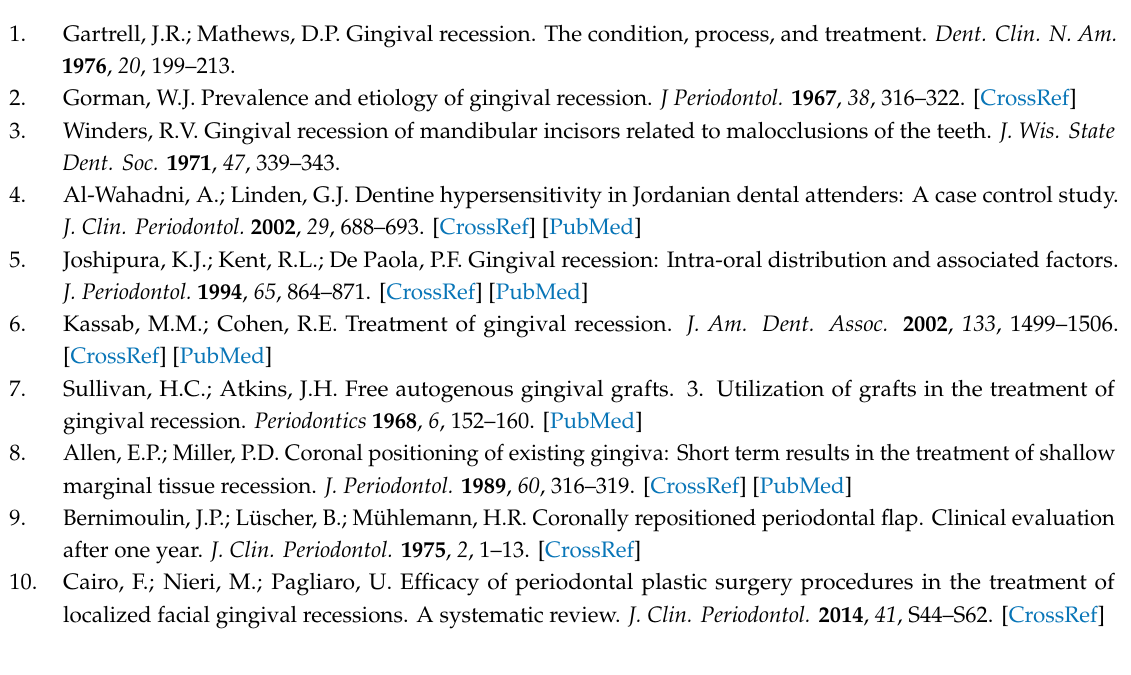
Figure S1a: Height of keratinized tissue, Figure S1b: Gingival